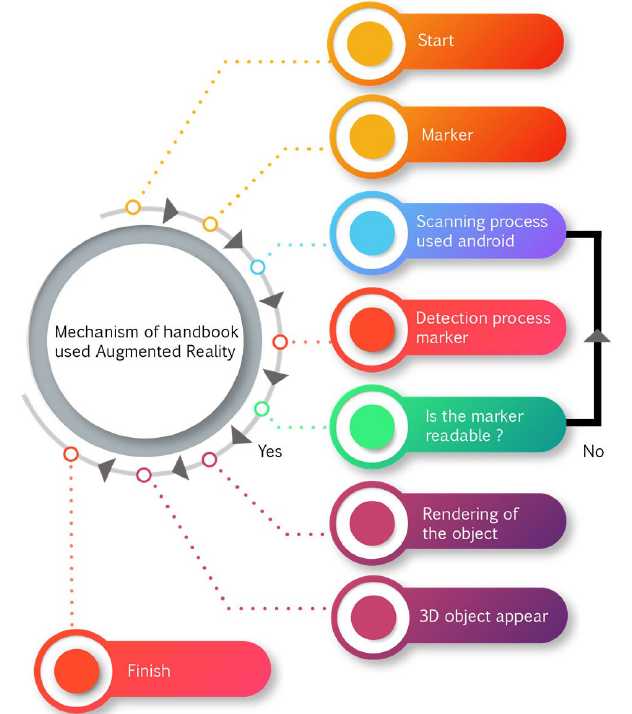
Figure 1. Mechanism of handbook used augmented reality